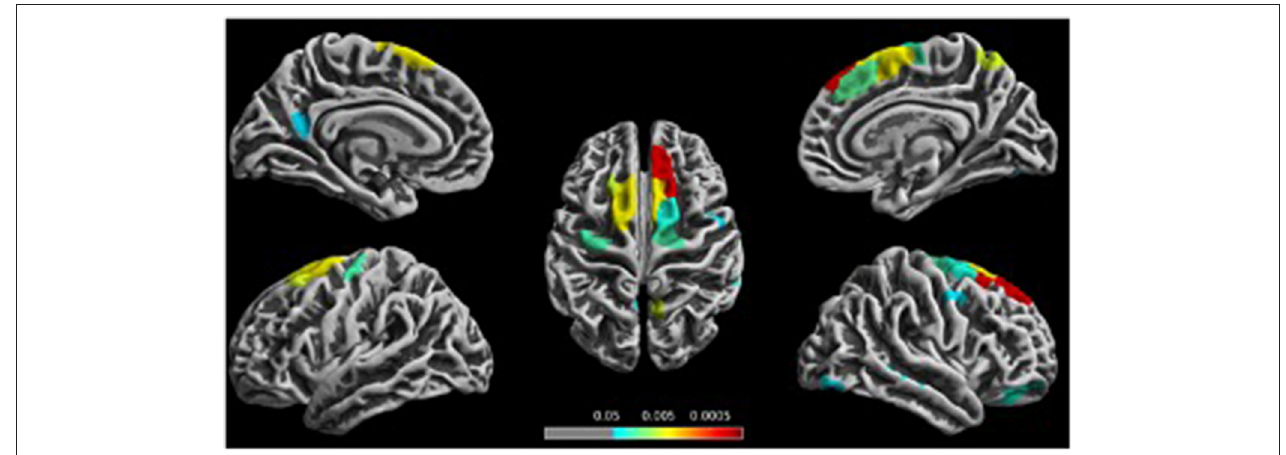
TABLE 3 | Brain regions showing smaller cortical thickness in chronic ketamine users. HemisphereOverlap of atlas region (Desikan–Klliany DK40)